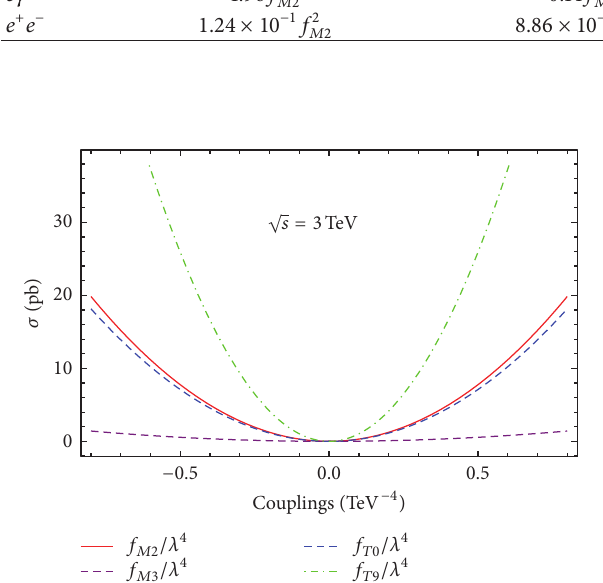
Figure 2: The total cross sections as function of anomalous 𝑓 𝑀2 /Λ 4 , /Λ 4 , 𝑓 /Λ 4 , and 𝑓 /Λ 4 couplings for the process 𝛾𝛾 → 𝑍𝑍 at 𝑓 𝑀3 𝑇0 𝑇9 CLIC with √𝑠 = 3 TeV.